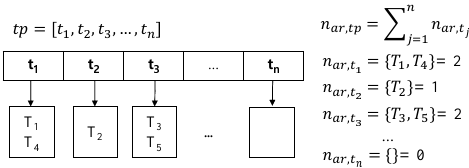
Figure 6. Computing pickup